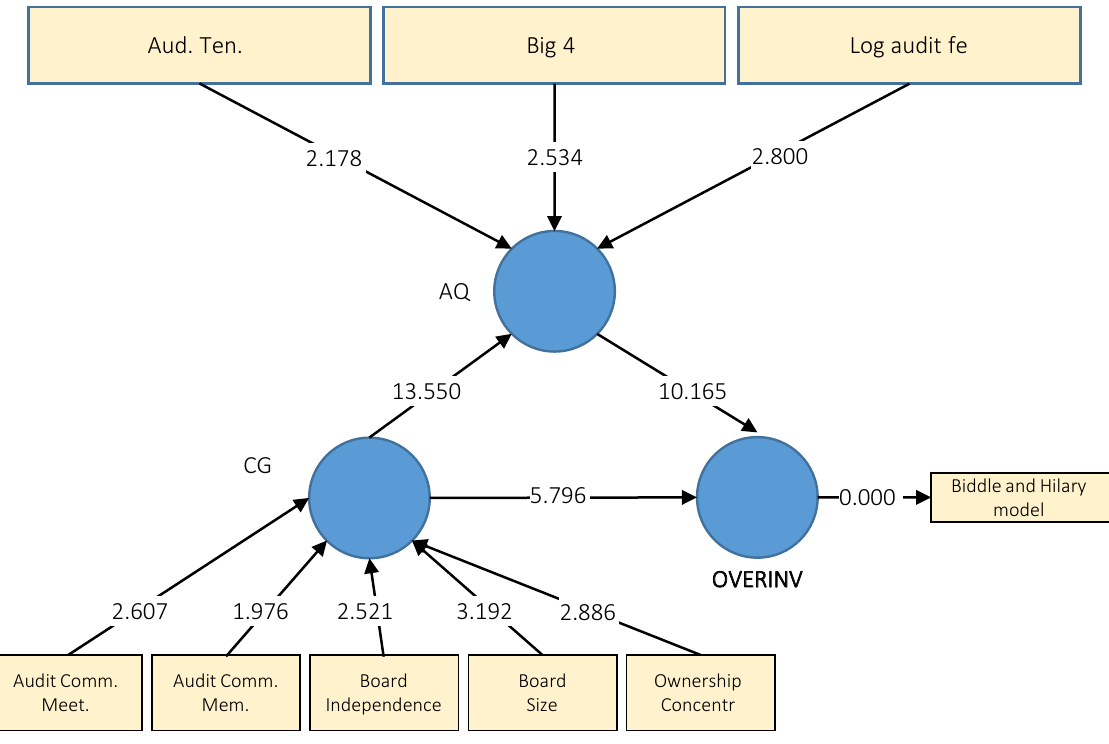
Figure 4. Measurement model (inner model), OVERINV